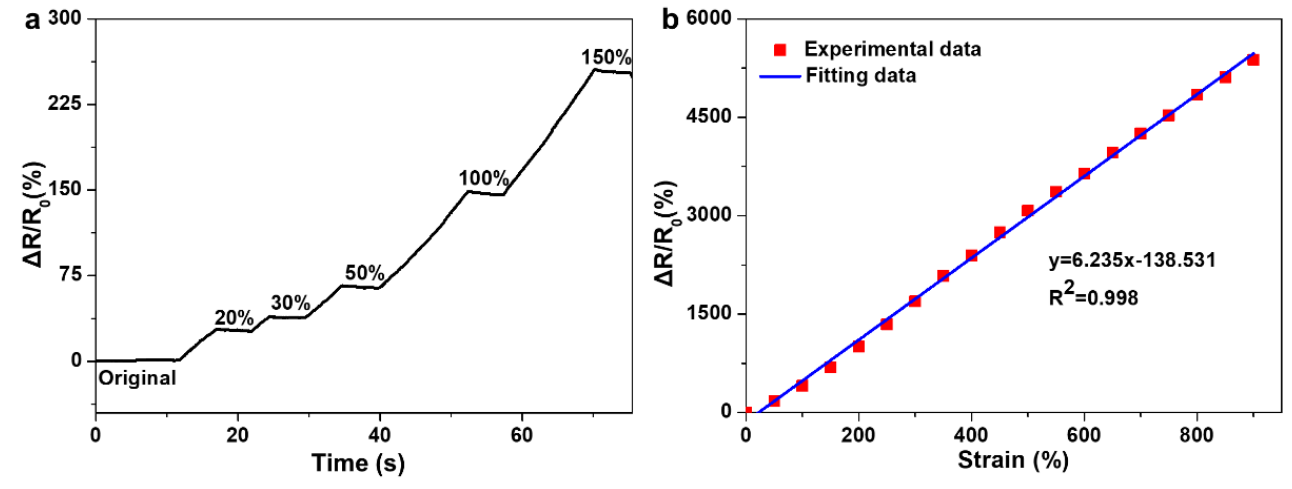
Figure 7. The relative resistance change of the CS/PAA DN ionogel with time ( a ) and the relative resistance change of the CS/PAA DN ionogel as a function of stretching strain ( b ).